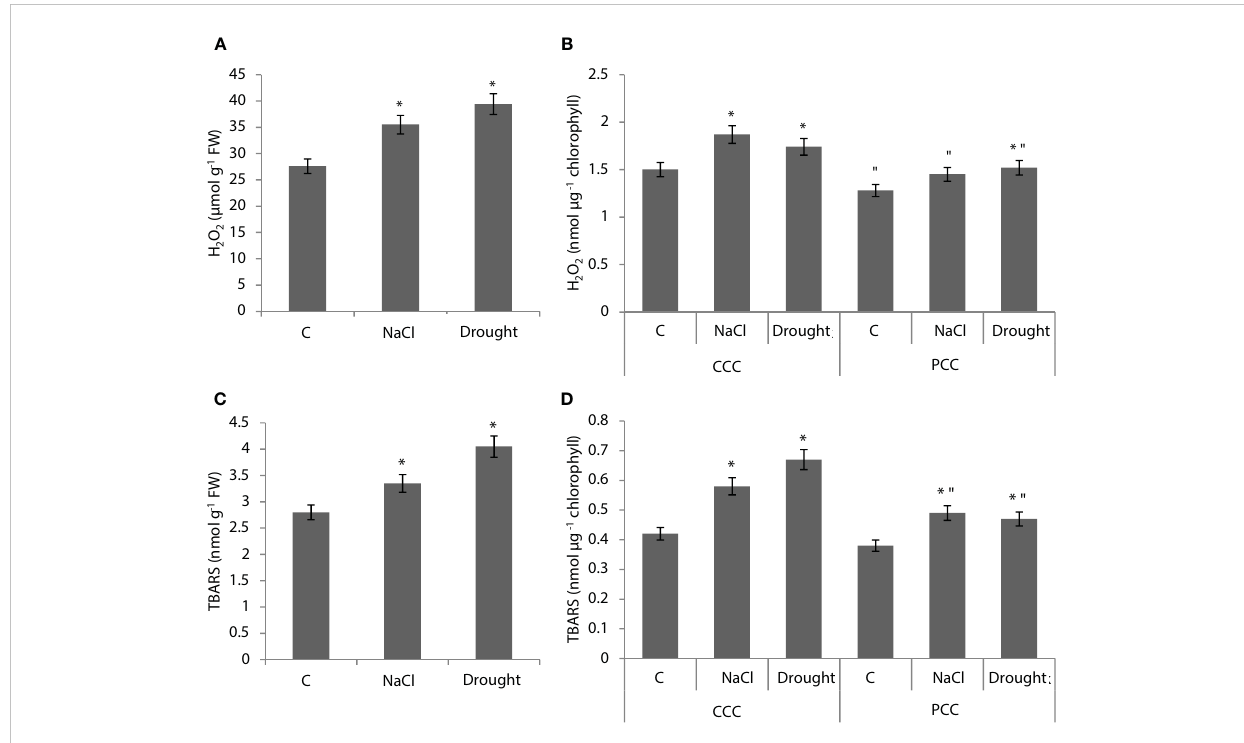
FIGURE 3 H2O2 (A, B) and lipid peroxidation (C, D) levels in whole leaves and dimorphic chloroplasts of Bienertia sinuspersici plants treated with 400 mM NaCl or water withholding for 10 d. * indicates signi fi cant difference (p < 0.05) as compared to controls. For central compartment chloroplasts (CCC) and peripheral compartment chloroplasts (PCC) groups are compared to their own controls. When effects of treatments are compared between CCC and PCC, signi fi cant differences are shown with “